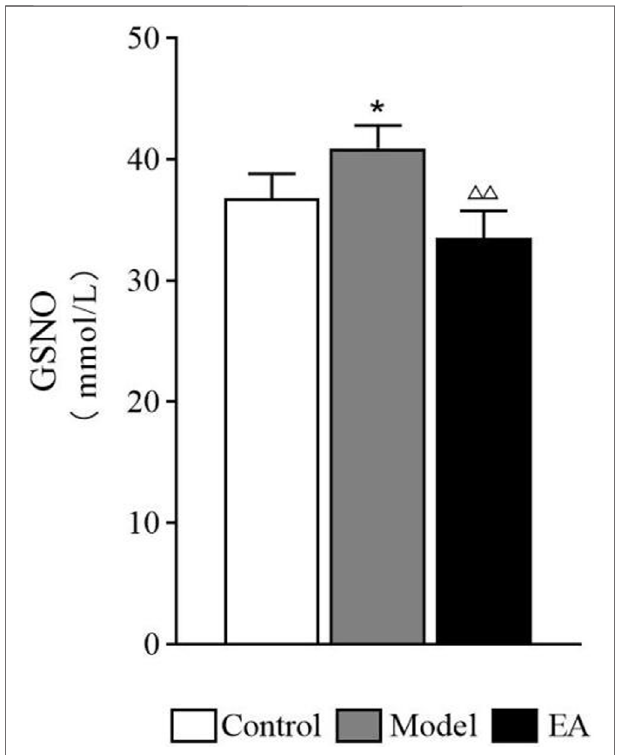
FIGURE 6 | Expression of GSNO in the colon. One-way ANOVA indicated that the level of GSNO shows a signi fi cant increase after modeling and a signi fi cant decrease after EA treatment. Bar: mean ± SE, n = 4, * p < 0.05, versus the control group, △△ p < 0.01, versus the model group.